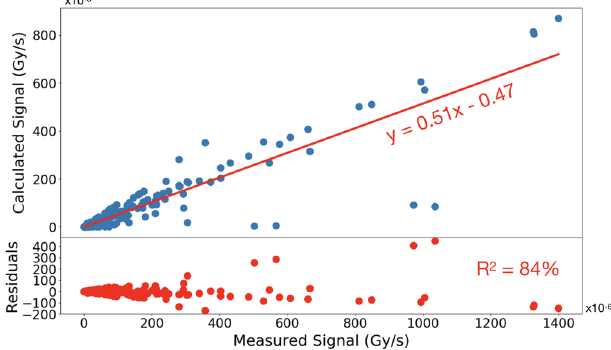
FIG. 11. Scatter plot of the loss map measured signal points above 10 − 7 Gy = s, against the calculated signal points, for the two skew collimators. A linear fit was applied to the data, and the fit residuals are presented in the lower plot.